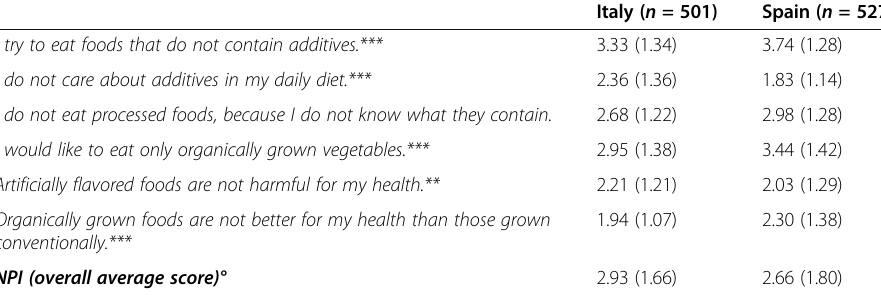
Wine drinking frequency